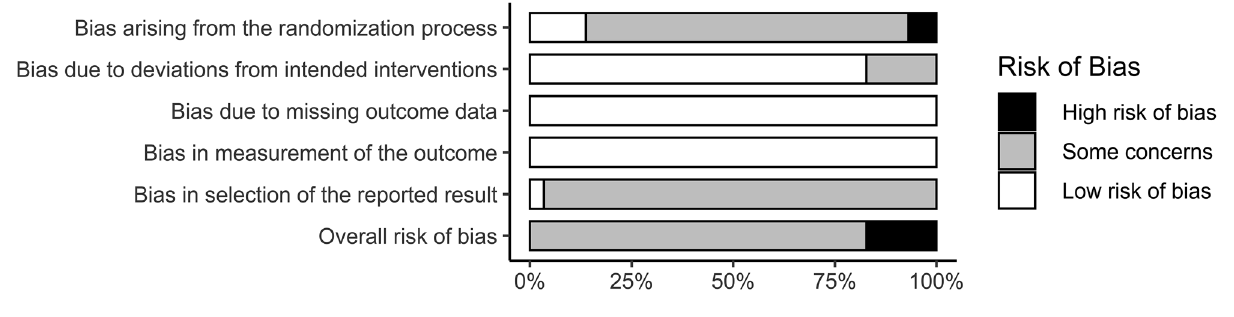
Figure 5. Risk of bias summary (k = 29).